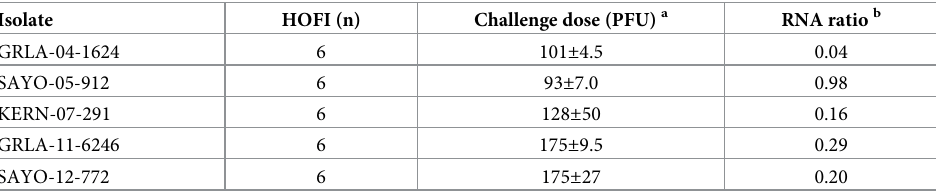
Table 3. HOFI competition challenge